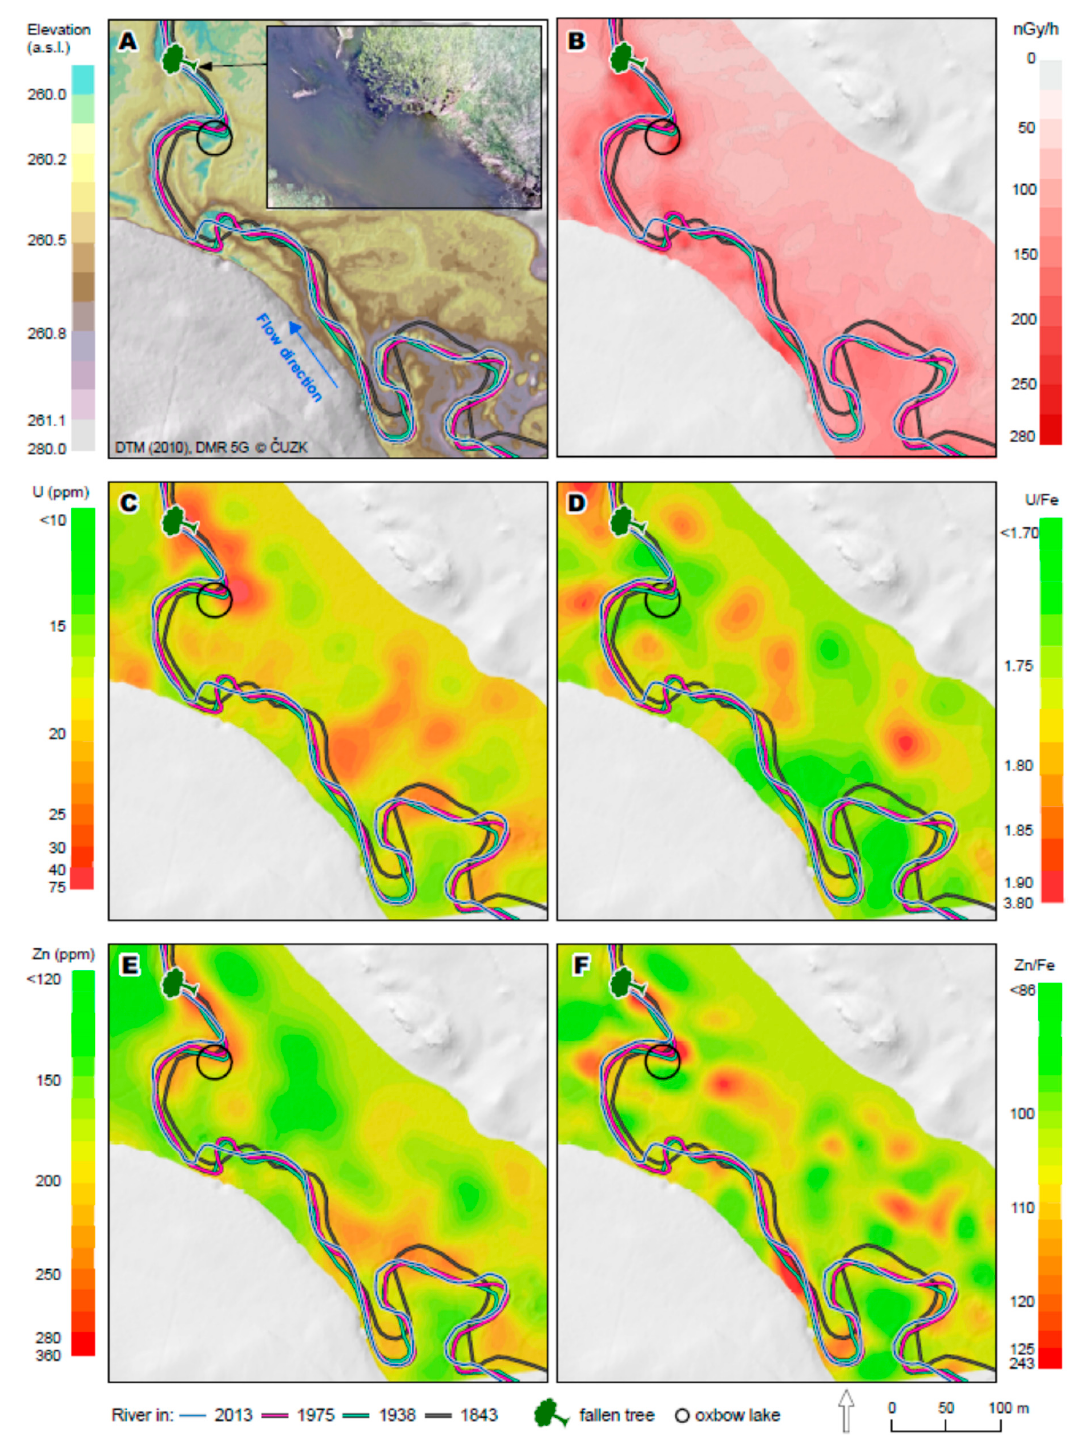
Figure 6. The MS-West of Hradˇcany study area. Digital terrain model and an aerial photograph (panel A ), gamma activity map (panel B ) and XRF maps of U (panel C ), the U/Fe ratio (panel D ), Zn (panel E ) and the Zn/Fe ratio (panel F ). Historical channel positions are also shown. Inset in panel A shows an aerial photograph of the tree remnant in the channel.